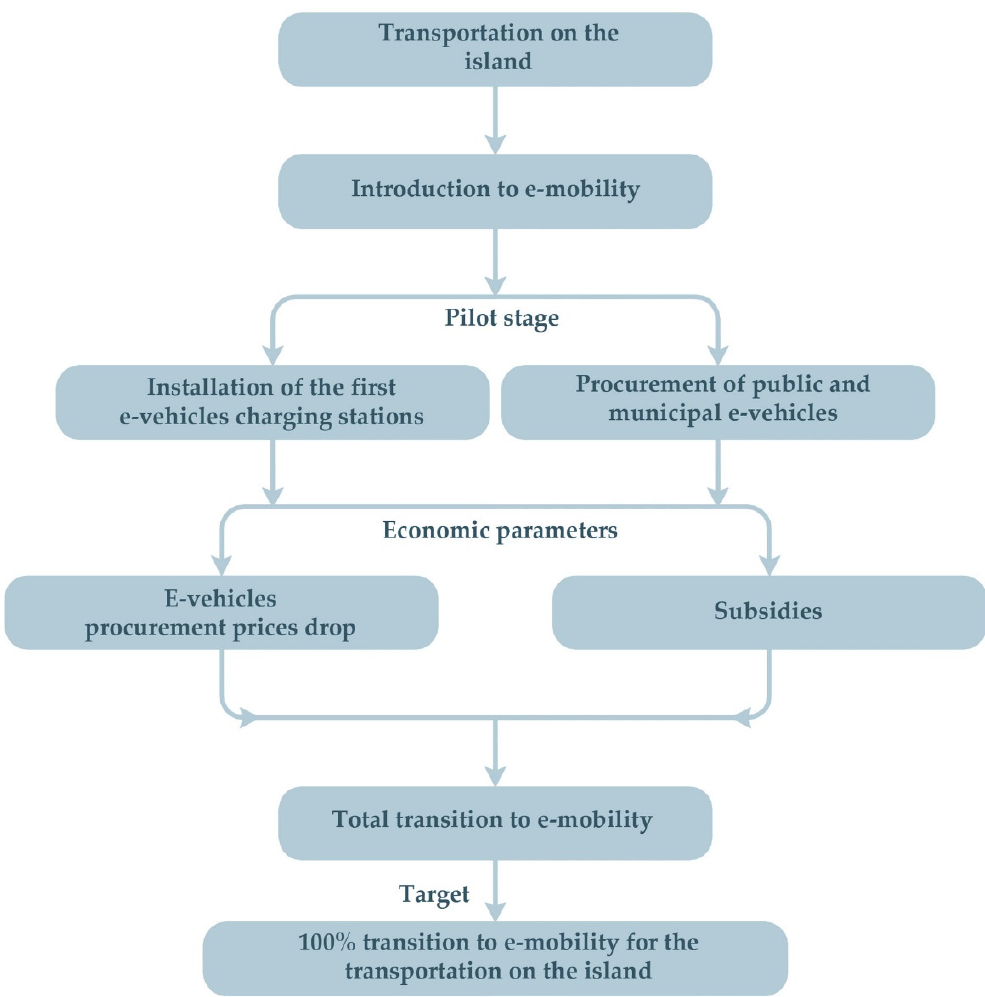
Figure 20. Target and roadmap towards energy transition on onshore transportation.